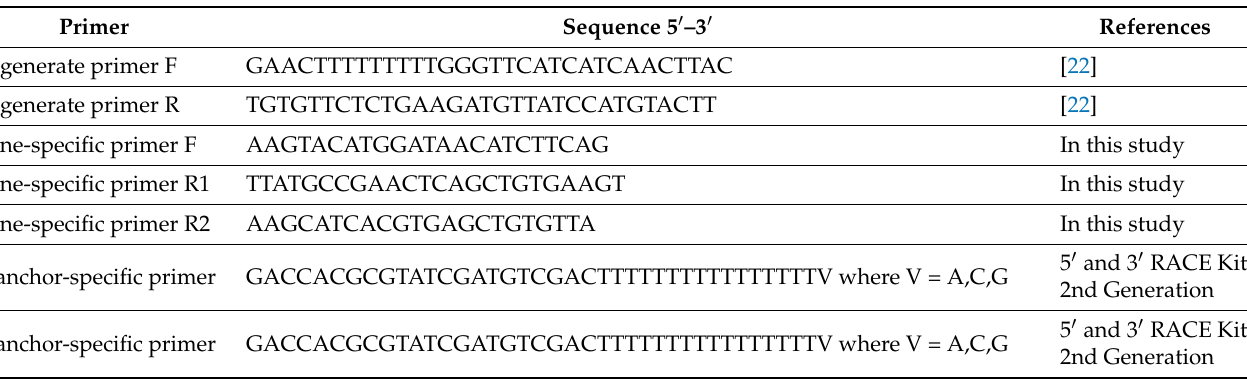
Table 1. Primers used in PCR amplification of E. verrucosa